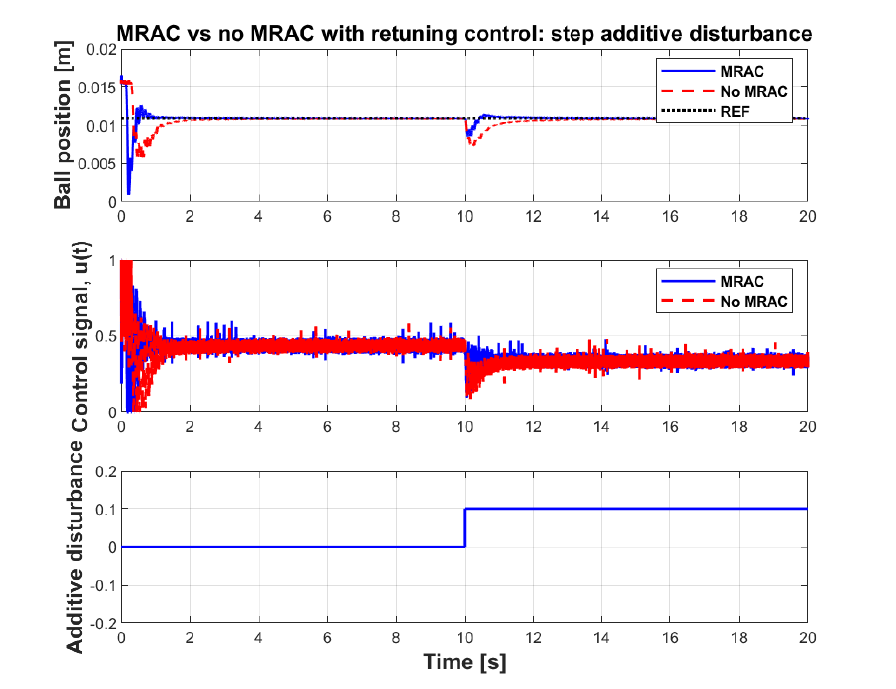
Figure 13. Step disturbance responses of the multi-loop MRAC-FOPID control with NARX reference model and the FOPID control loop (When MRAC is